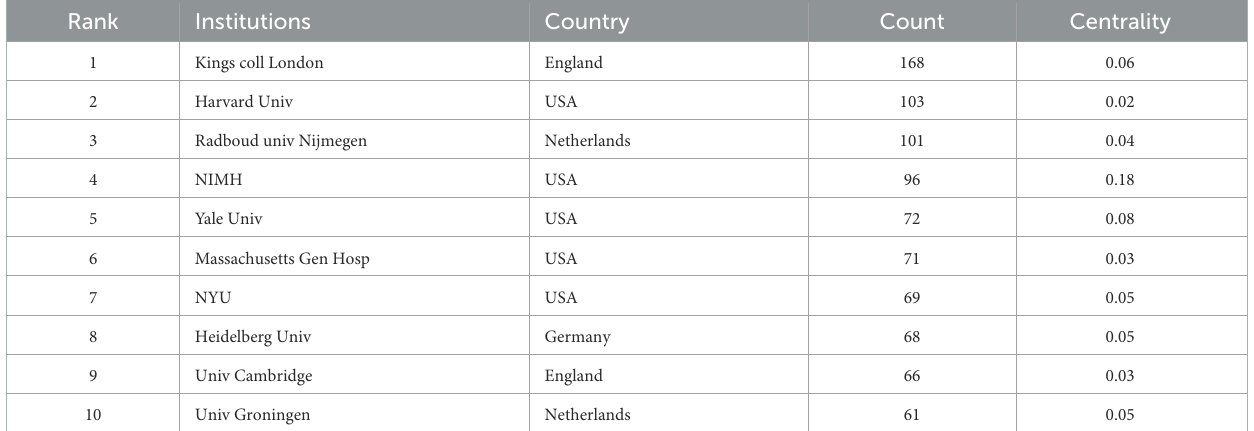
TABLE 2 Top 10 institutions with publications on ADHD neuroimaging from 1992 to